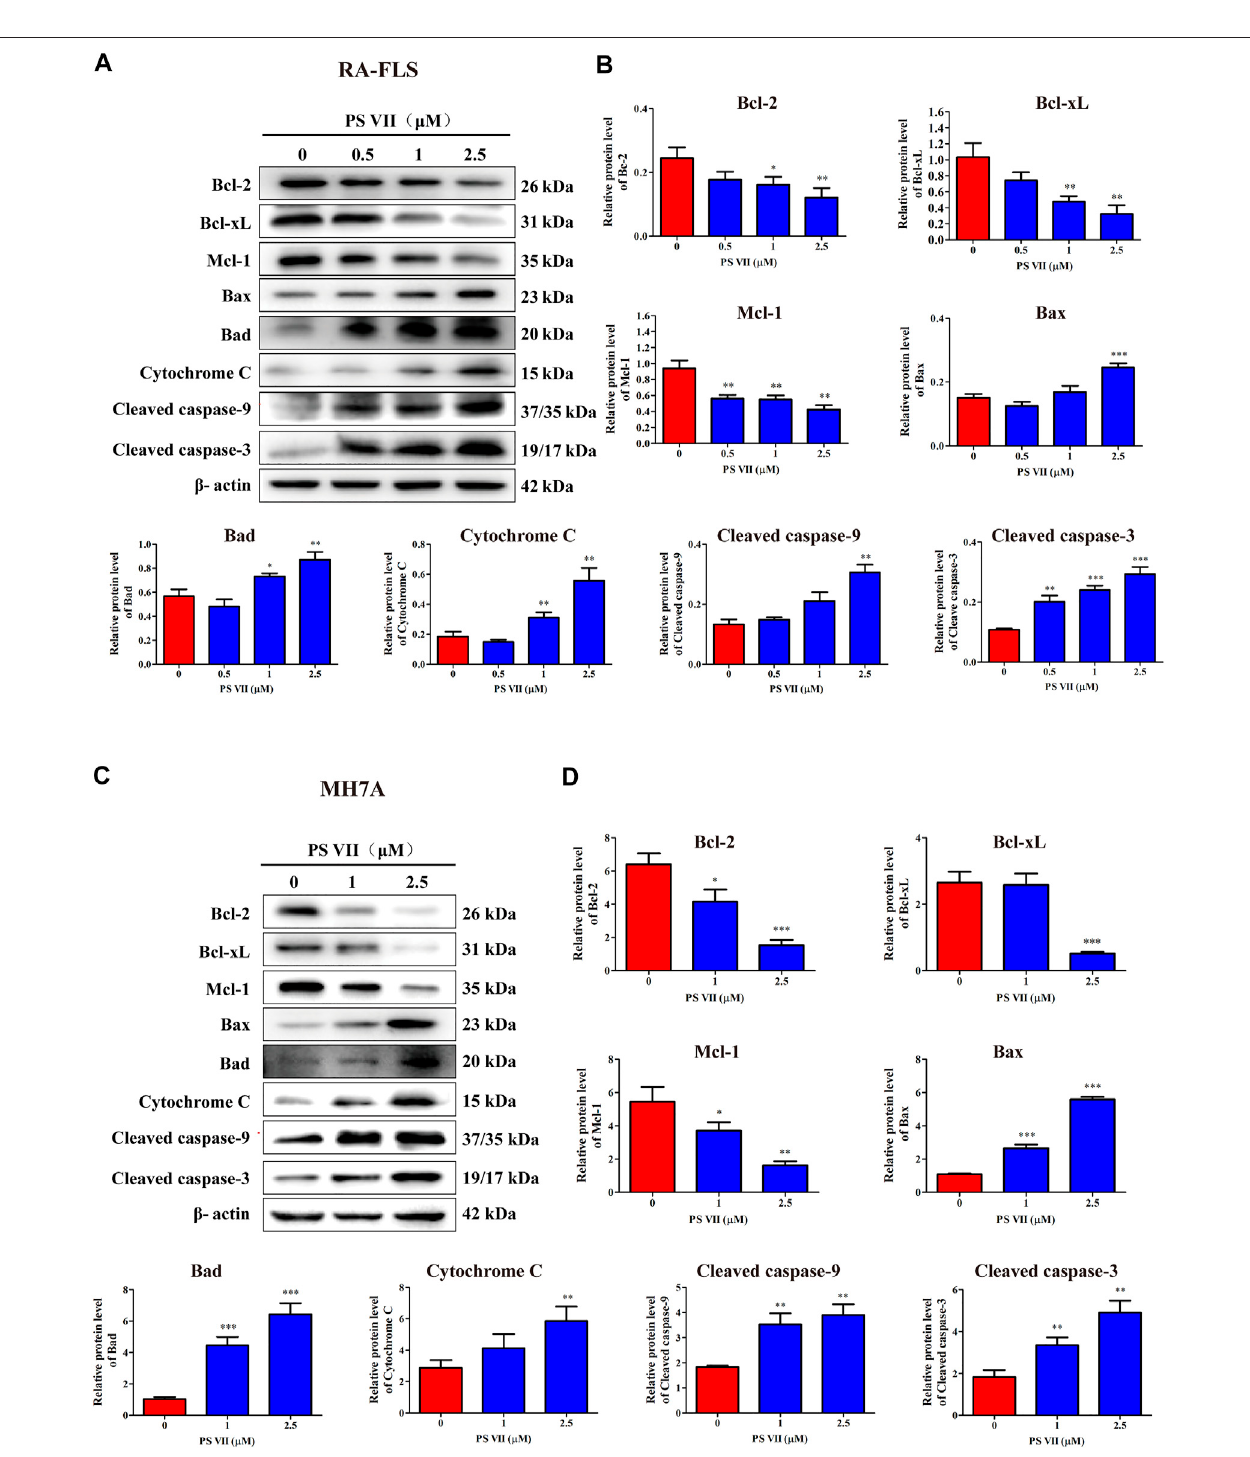
FIGURE 5 | Effects of PS VII on the expression level of mitochondrial apoptosis pathway related proteins in RA-FLS and MH7A cells. Cells were treated with the indicated concentrations of PS VII for 48 h. The expression of apoptosis-related proteins in RA-FLS (A) and MH7A (C) was detected by western blot analysis. (B, D) Relative protein expression was determined by optical density analysis. Image J was used to determine the density ratio of each protein band relative to β -actin band. Compared with the control group, * p < 0.05, ** p < 0.01, *** p < 0.001.